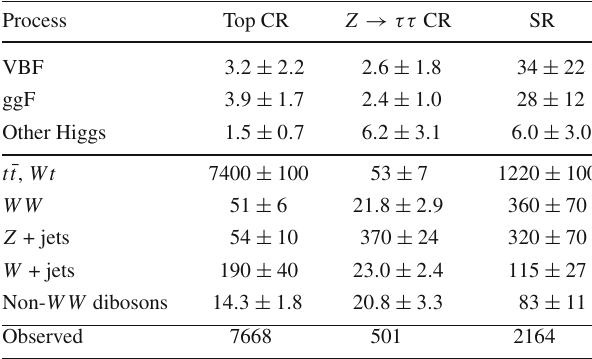
Table 8 Post-fit event yields in the signal and control regions obtained from a scan over ε VV exploiting both shape and rate information. The quoted uncertainties include those from theoretical and experimental systematic sources and those due to sample statistics. The fit constrains thetotalexpectedyieldstotheobservedyields.Thedibosonbackground is split into WW and non- WW